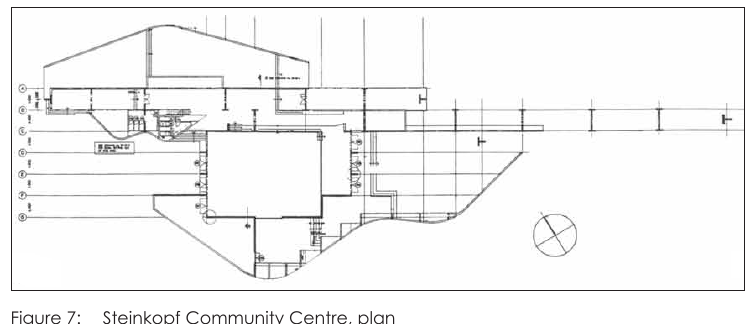
Figure 7: Steinkopf Community Centre, plan